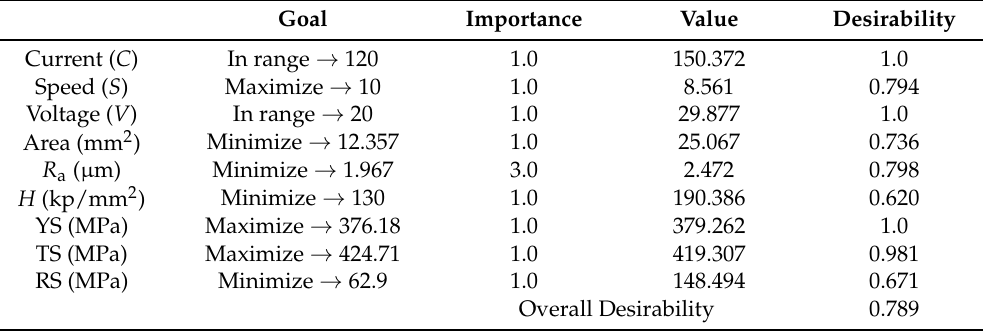
Table 14. The fifth criterion considered: welded joint quality based on surface